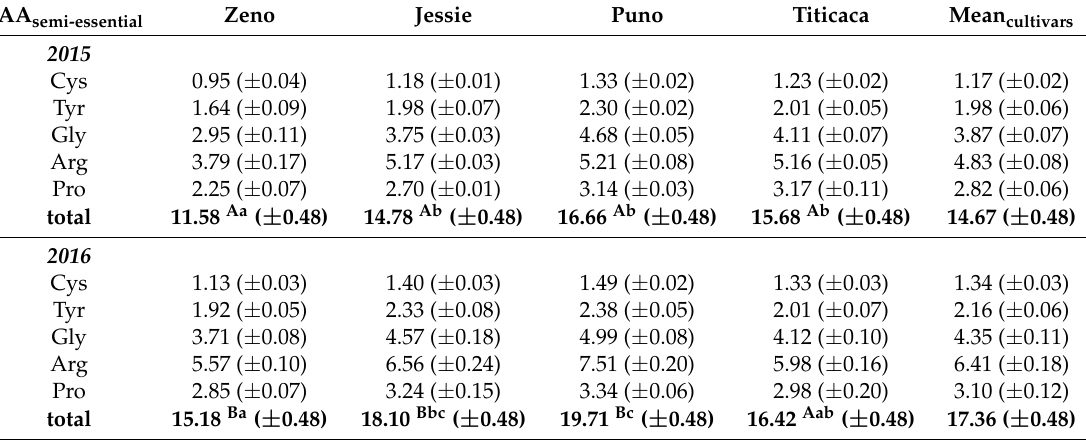
Table 6. Composition of semi-essential amino acids (AA) (in g 100 g − 1 crude protein, ± SE 1 ) for the two years and four quinoa cultivars (Zeno, Jessie, Puno, Titicaca). Total amount means within year in one row followed by the same lower-case letter are not significantly different from each other ( p < 0.05). Capital letters compare the two years for the same cultivar, means in one column followed by the same letter are not significantly different ( p <